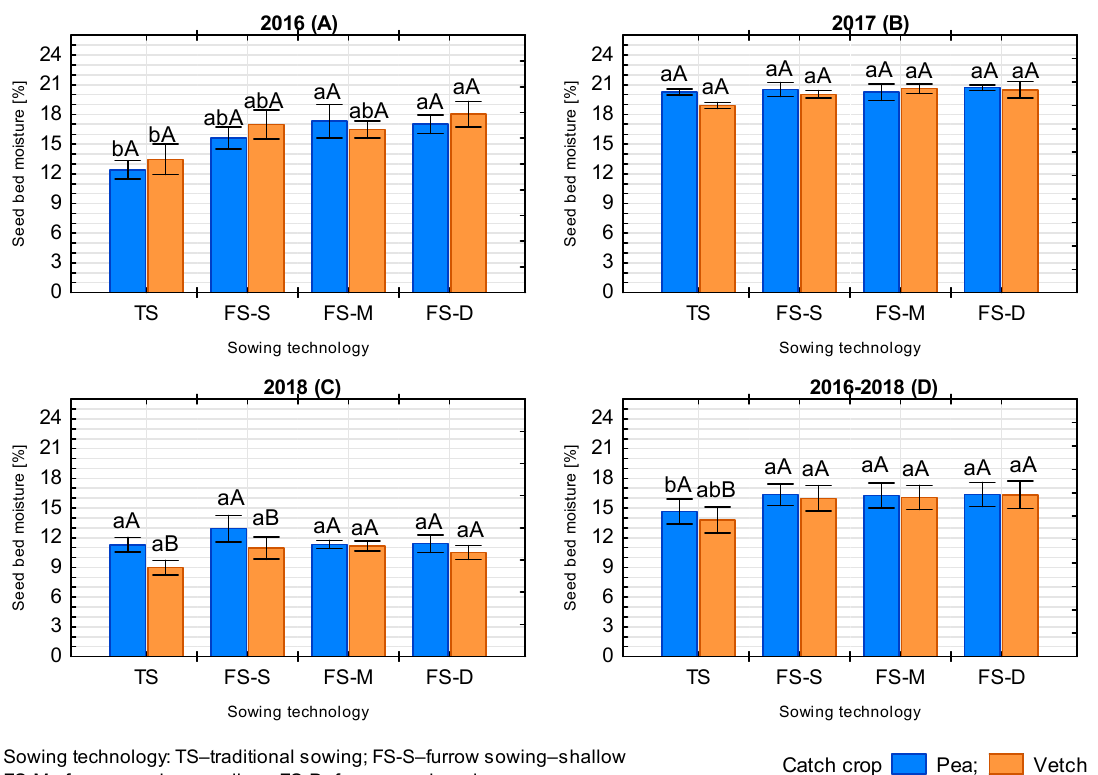
Figure 6. Seedbed moisture eight days after sowing the seeds [% vol]. a,b—homogenic groups HSD ( p = 0.05) interaction for sowing method/species (the differences between the four methods of sowing separately for pea and for vetch). A,B—homogenic groups HSD ( p = 0.05) interaction for species/sowing method (differences between pea and vetch for each sowing method).